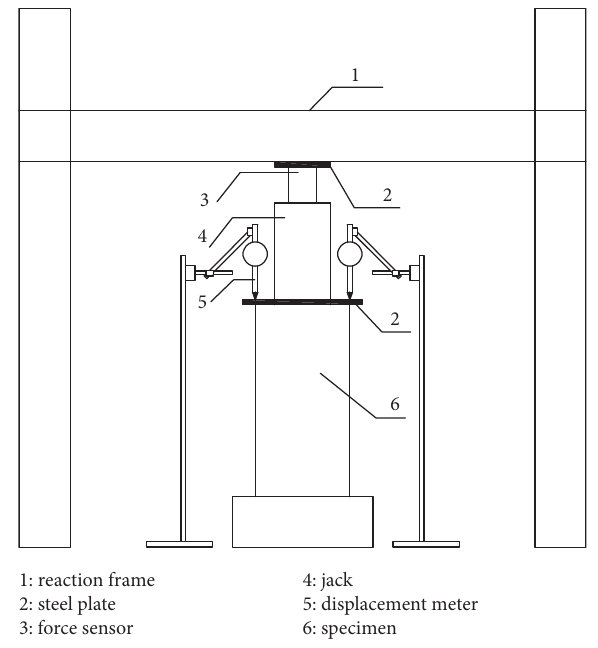
Figure 3: Loading device of